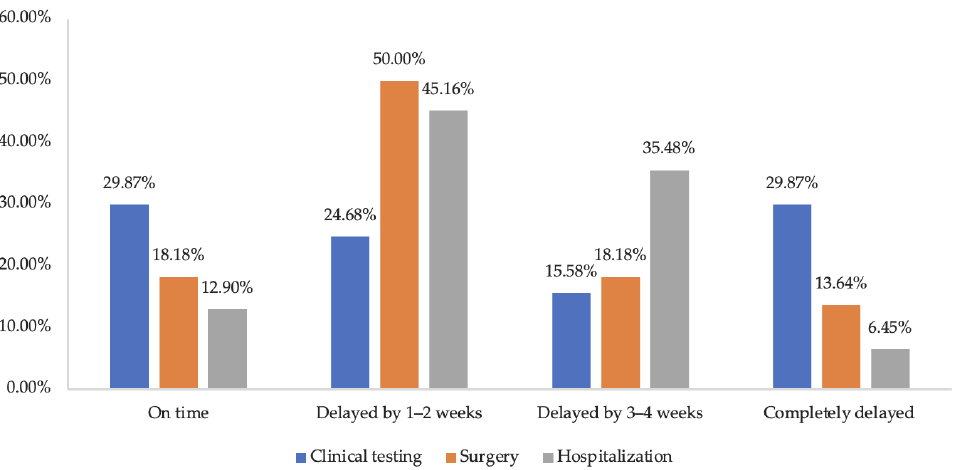
Figure 3. Health services appointment in chronic diseases respondents during the COVID-19